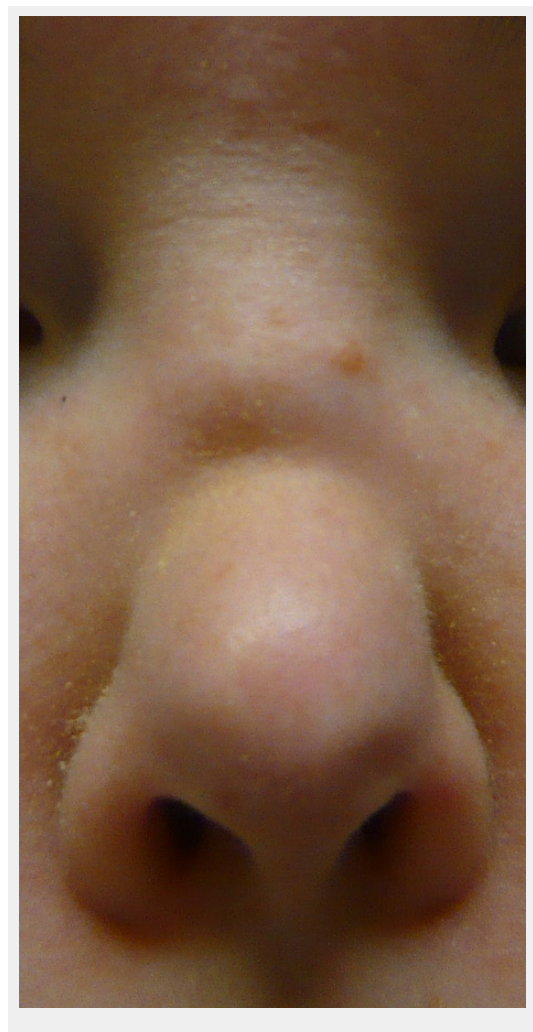
Nasal deformity in a patient with granulomatosis with polyangiitis (GPA). (Written informed consent for publication has been obtained from the patient.)